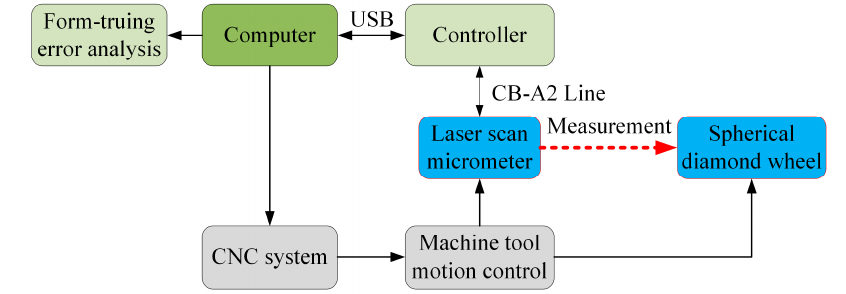
Figure 2. Principle of in-situ measurement system.